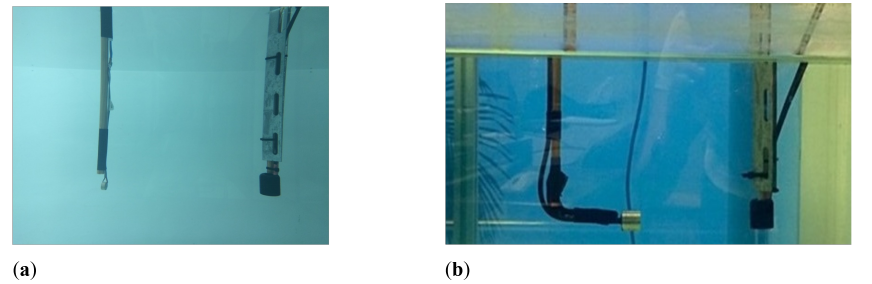
Figure 8. Experimental measurements. ( a ) Free ceramic in water; ( b ) Sensor in